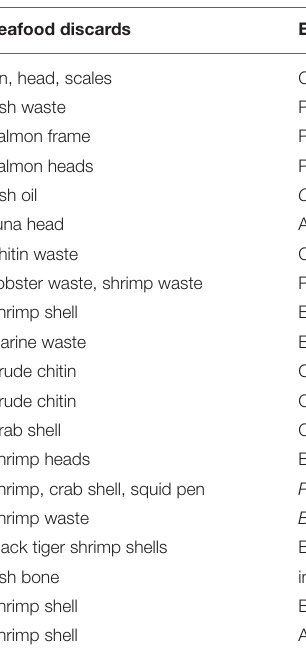
TABLE 5 | Bioconversions of seafood processing discards by